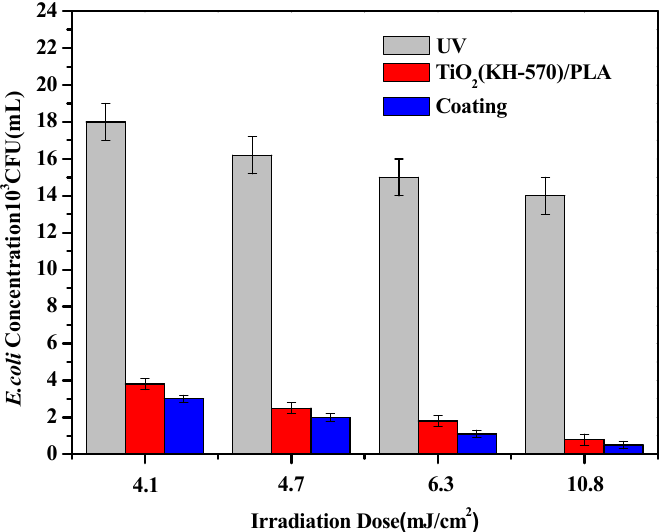
Figure 14. The sterilization effect of different materials of the water processor under different light radiation intensities.